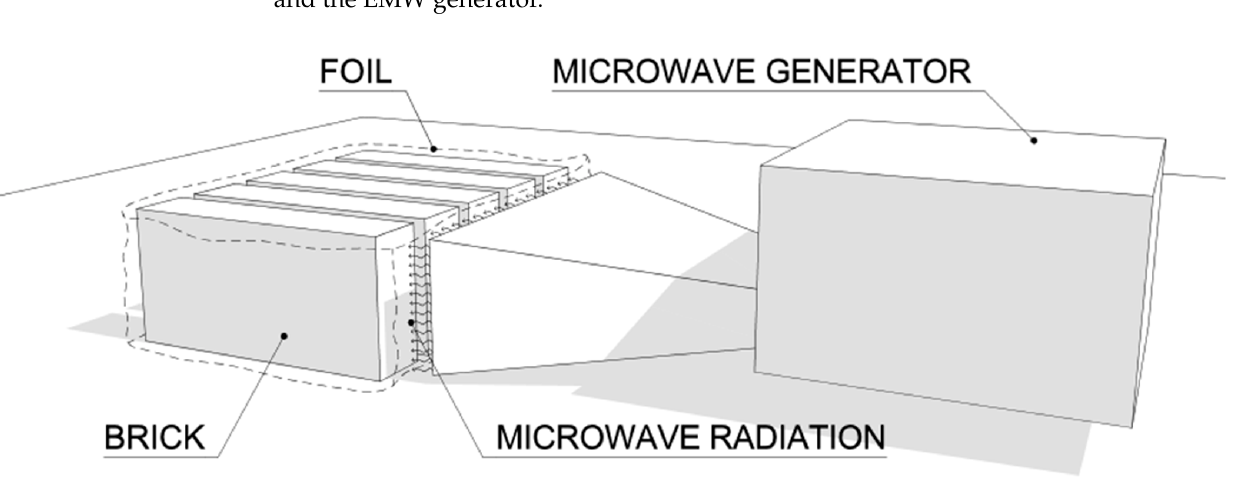
Figure 1. Scheme of the microwave generator assembly for ceramic brick exposure.